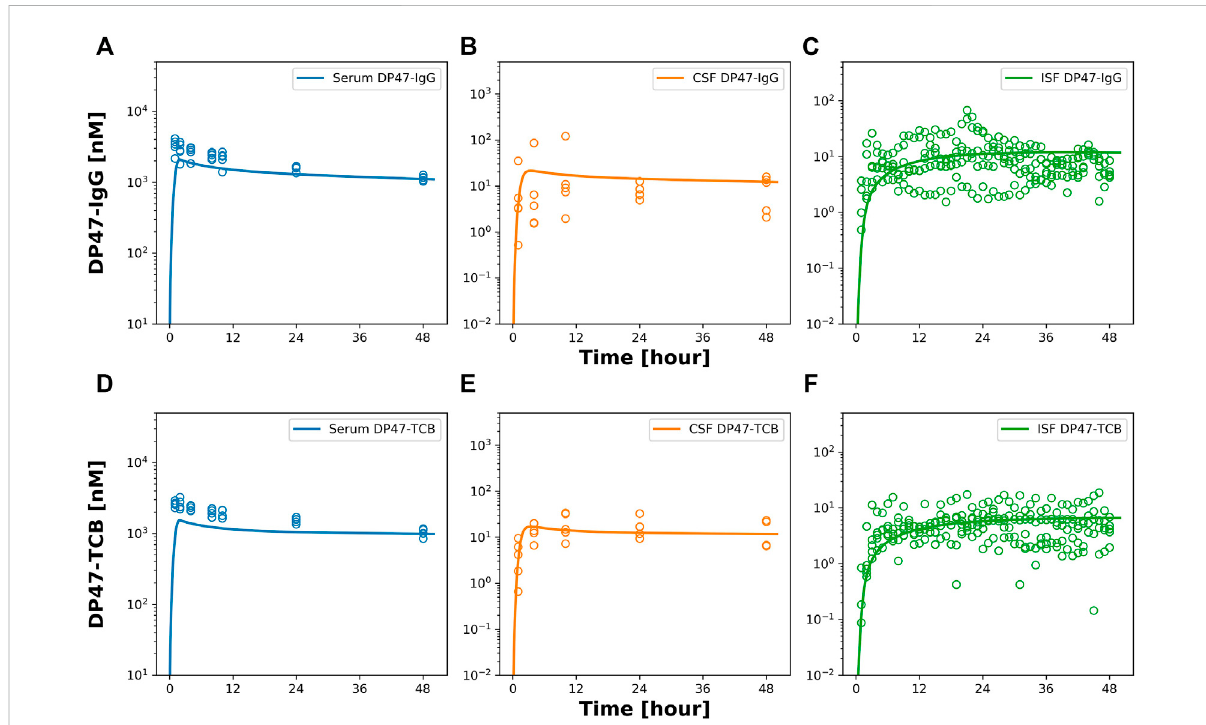
FIGURE 6 ObservedandmodelpredictedPKinserum,CSFandISFafter15 mg/kgivdosing ofDP47-IgGandDP47-TCB.Figure6showsmodelpredicted (solidlines)andindividuallyobservedPKdata(symbols)after15 mg/kgivdosingofDP47-IgG (A – C) andafter15 mg/kgivdosingofDP47-TCB (D – F) in serum (blue, (A,D) ) in CSF (orange, (B,E) ) and ISFbrain (green, (C,F)